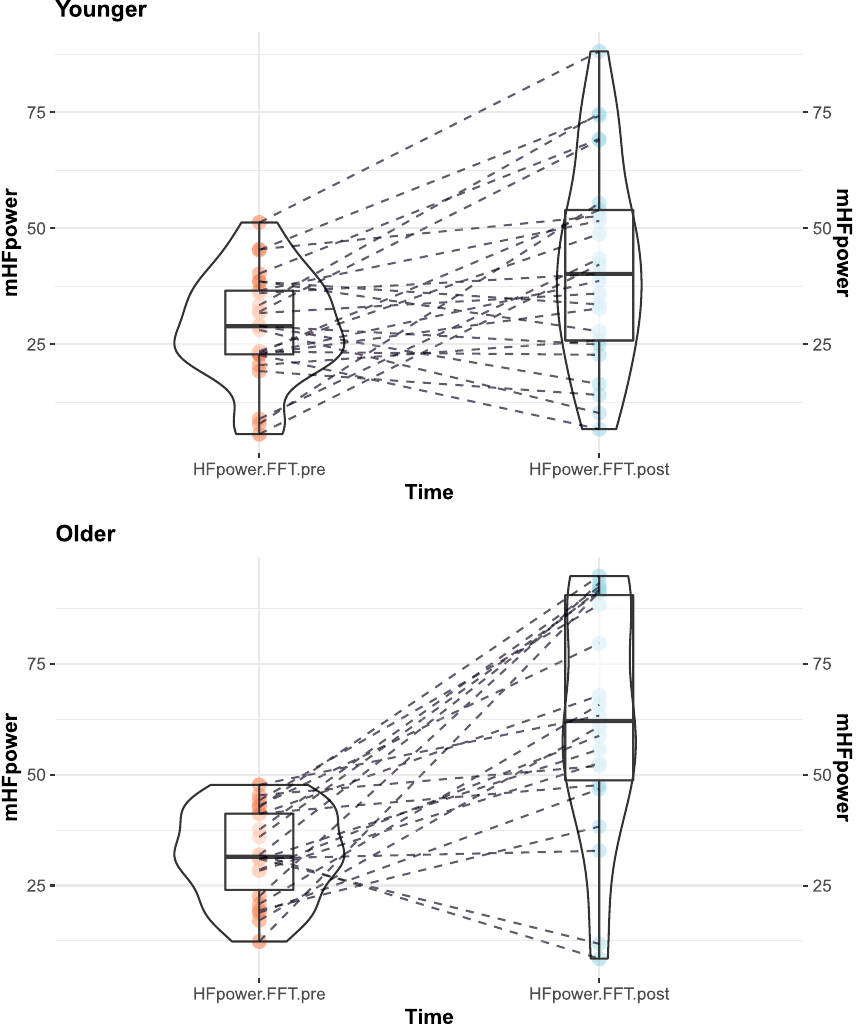
Figure 1. Effect of the interaction between time and age on